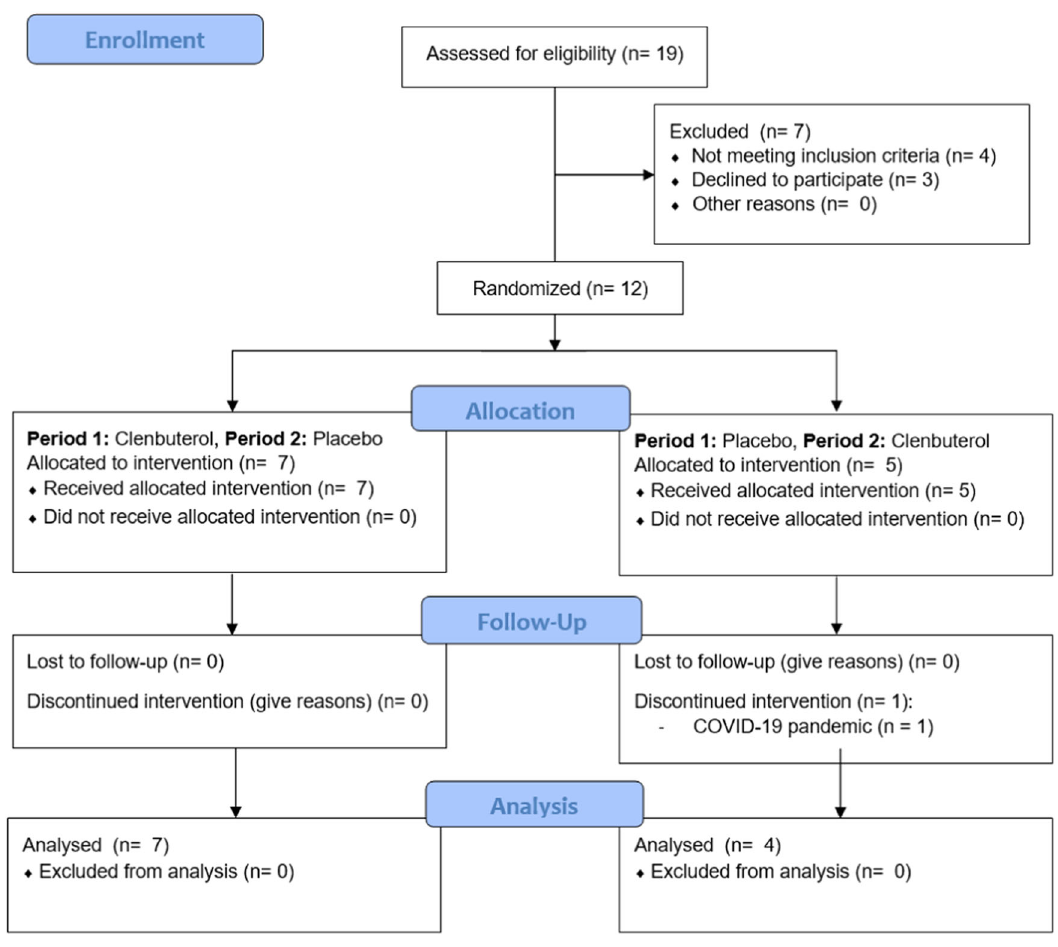
Fig. 1 | CONSORT diagram inclusion fl ow-chart of the study. P1 period 1, P2 period